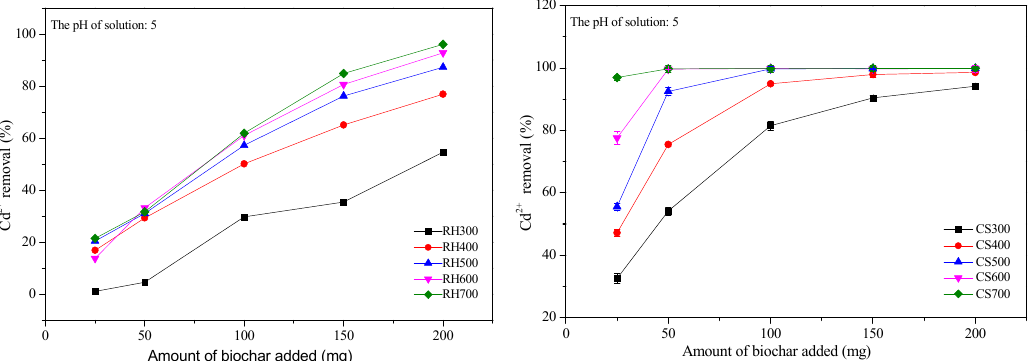
Figure 3. Effect of the addition of various biochar amounts on Cd 2+ removal. Notes: RH300, RH400, RE500, RH600, and RH700 indicate that rice husk were pyrolyzed at 300, 400, 500, 600 and 700 °C, respectively; CS300, CS400, CS500, CS600, and CS700 indicate that cotton straw were pyrolyzed at 300, 400, 500, 600 and 700 °C, respectively.